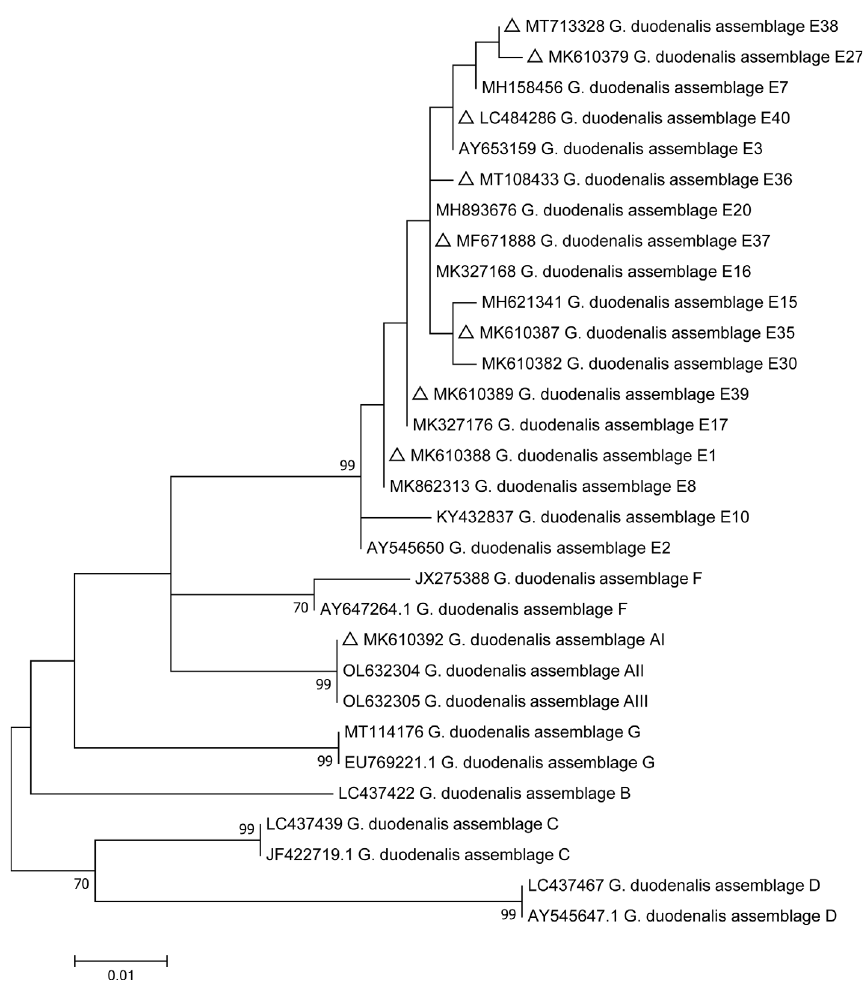
Figure 2. Phylogenetic relationships of beta-giardin ( bg ) nucleotide sequences of G. duodenalis assemblages (A – G) and assemblage E subtypes, using the maximum composite likelihood model. Percent bootstrap values greater than 50% from 1000 replicates are shown next to the branches. The hollow triangles represent published isolates in this